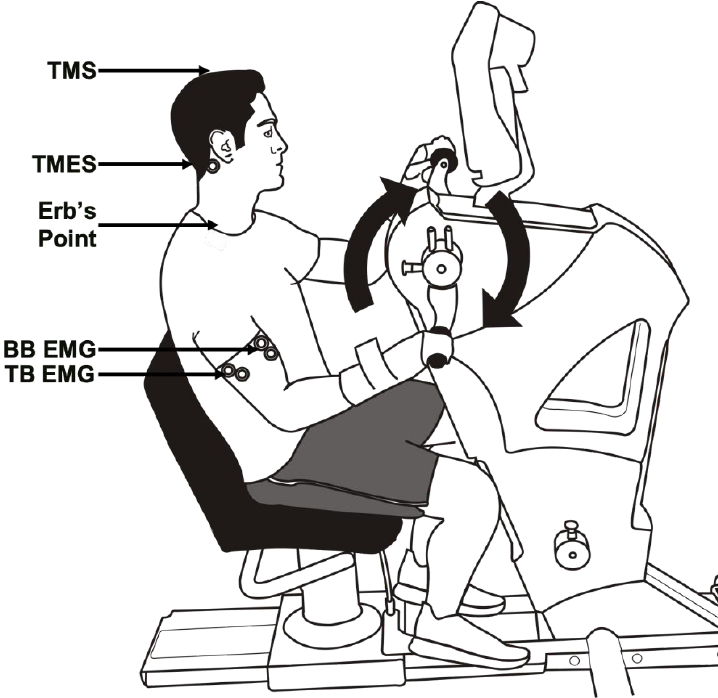
Figure 1. Experimental setup for arm cycling trials showing participant seated on the ergometer instrumented with surface EMG electrodes on the biceps and triceps brachii. Arrows point to the site of each stimulation technique. All arm cycling trials were conducted in the forward direction.